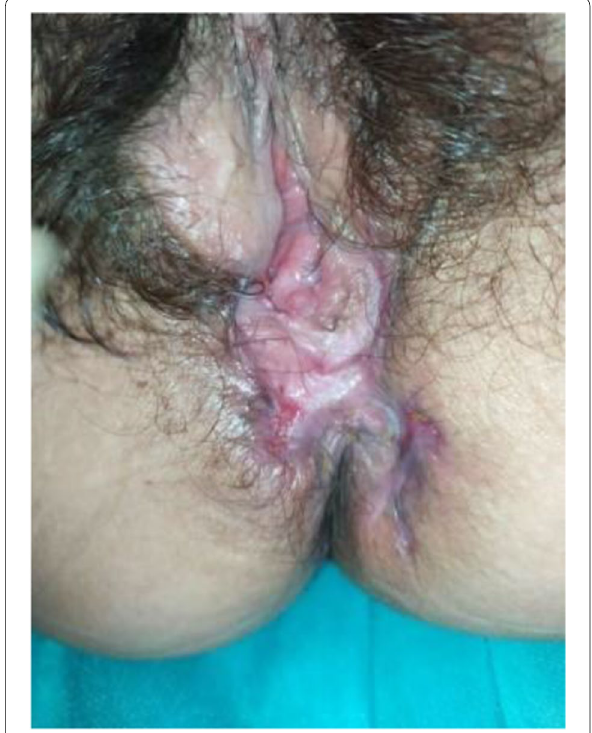
Fig. 2 A pseudo folliculitis on the left